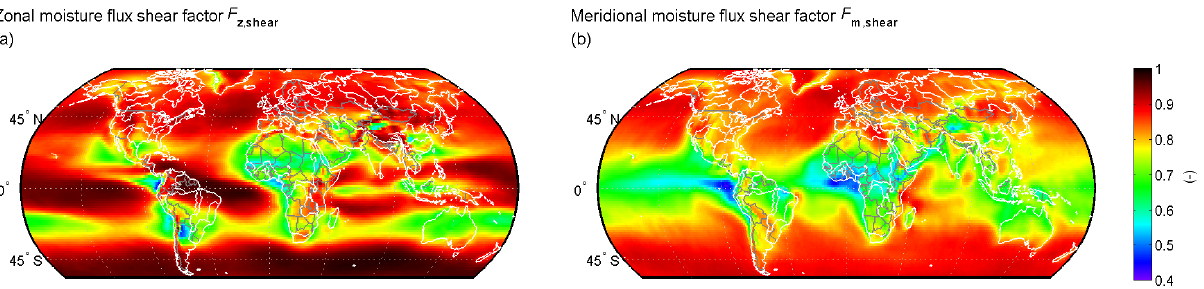
Fig. 11. Horizontal moisture flux shear factors as defined by Eqs. (7) and (8) averaged over 1999–2008 according to ERA-Interim reanalysis. (a) Zonal moisture flux shear factor, and (b) meridional moisture flux shear factor. The lower the value the more sheared the moisture